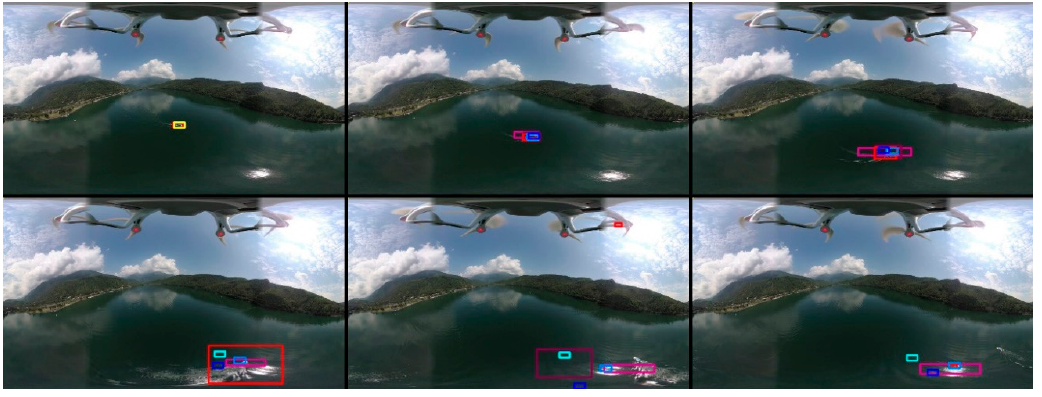
Figure 9. Tracking results on 360-degree video sequence 6 (tracking windows with different colors: MOSSE MIL MedianFlow BOOST TLD KCF GOTURN CSRT).